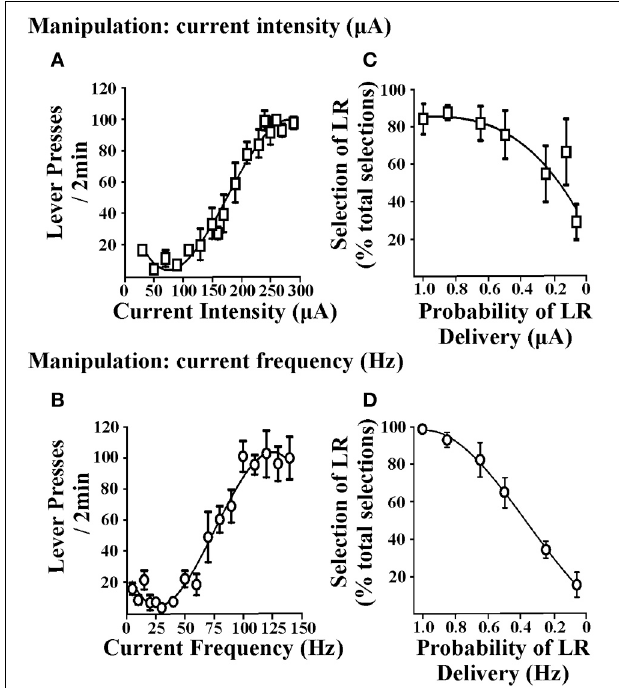
FIGURE 1 | Effects of brain stimulation parameters on lever-press responding and probability discounting. The two EBS parameters tested were current intensity and current frequency. Rats lever pressed for EBS (in a fixed ratio-1 schedule of reinforcement) wherein every 2min, one parameter of EBS was manipulated and the other parameter was held constant. (A) Manipulation of current intensity. Current intensities ranging from 10 to 350 µ A were presented in randomized order ( n = 6); current frequency was held at 100Hz. (B) Manipulation of current frequency. Current frequencies ranging from 5 to 140Hz were presented in randomized order ( n = 3); current intensity was held constant at a level that was individualized and determined in prior training sessions. Manipulating current intensity or current frequency produced similar patterns of lever-press responding. Data are shown as mean ± s.e.m. for the last three consecutive sessions. Rats were subsequently trained in the probability discounting task and values for the small and large reinforcers were determined individually for each animal by computing the effective stimulation current intensities and current frequencies obtained from the EBS vs. lever-press responding curve that elicited 60 and 90% of maximal lever-press response rates, respectively. Varying the magnitude of current intensity (C) or current frequency (D) resulted in discounting the large reinforcer (LR) as the probability of delivery was decreased (i.e., decrease in percent selection of the lever associated with the LR over total selections). Data are shown as mean ± s.e.m. for day one of discounting using current intensity and 2 days of discounting using current frequency. Figure modified from Rokosik and Napier (2011) and reprinted with permission from the